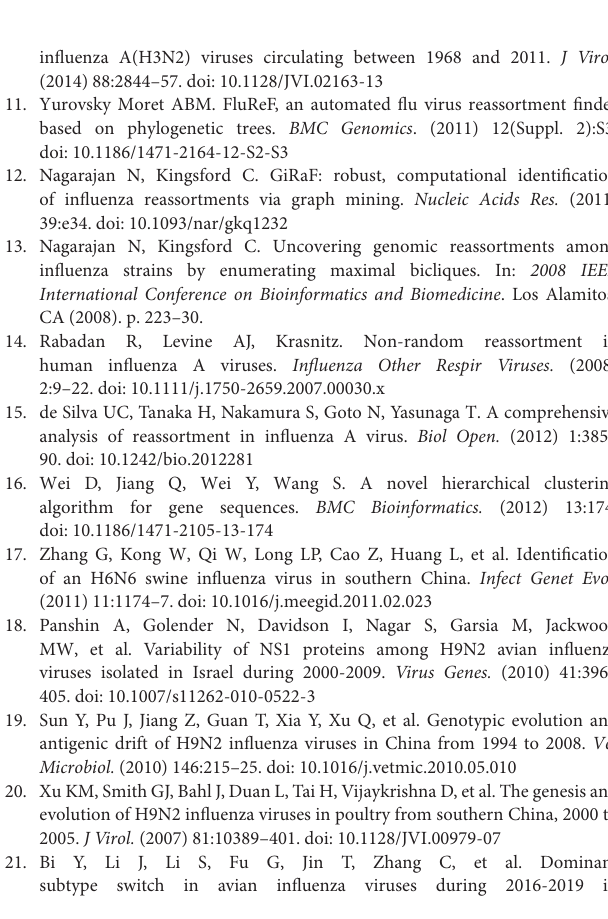
Supplementary Table 1 | The clustering results for PB2 segments. Supplementary Table 2 | The clustering results for PB1 segments. Supplementary Table 3 | The clustering results for PA segments. Supplementary Table 4 | The clustering results for HA segments. Supplementary Table 5 | The clustering results for NP segments. Supplementary Table 6 | The clustering results for NA segments. Supplementary Table 7 | The clustering results for MP segments. Supplementary Table 8 | The clustering results for NS segments. Supplementary Table 9 | The details of each reassortment event. Supplementary File 1 | AsiaGenome.zip (Genome data used in this